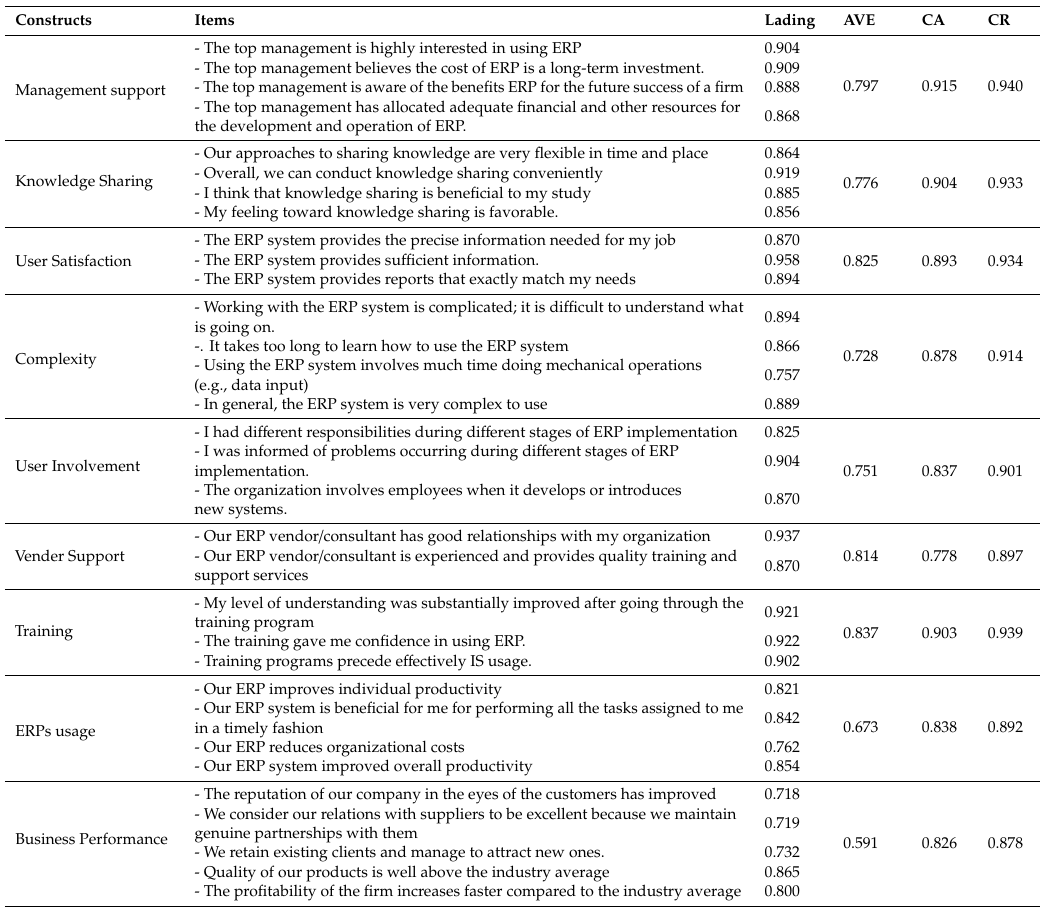
Table 4. Validity and reliability for the